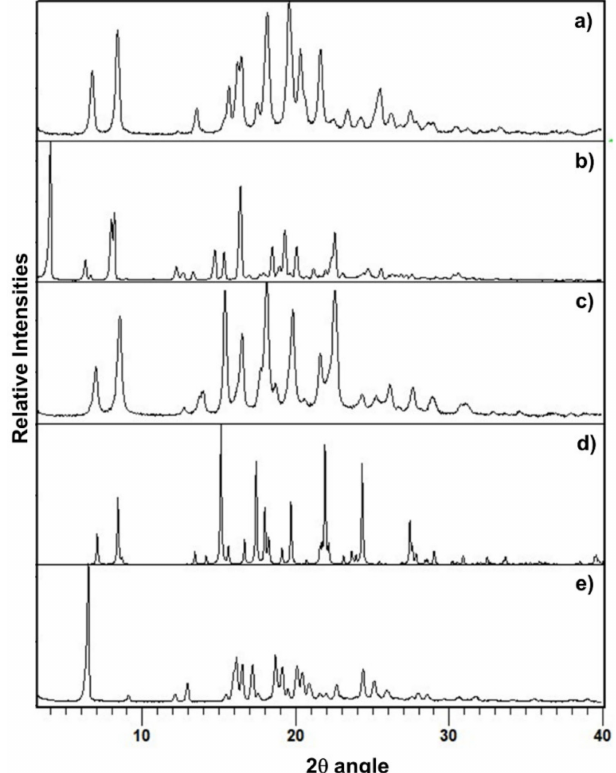
Figure 2. PXRD pattern of ( a ) Form B, ( b ) Form A, ( c ) Form C, ( d ) the calculated pattern from CSD of the enantiomeric hemihydrate SIGBUG and ( e ) the new racemic